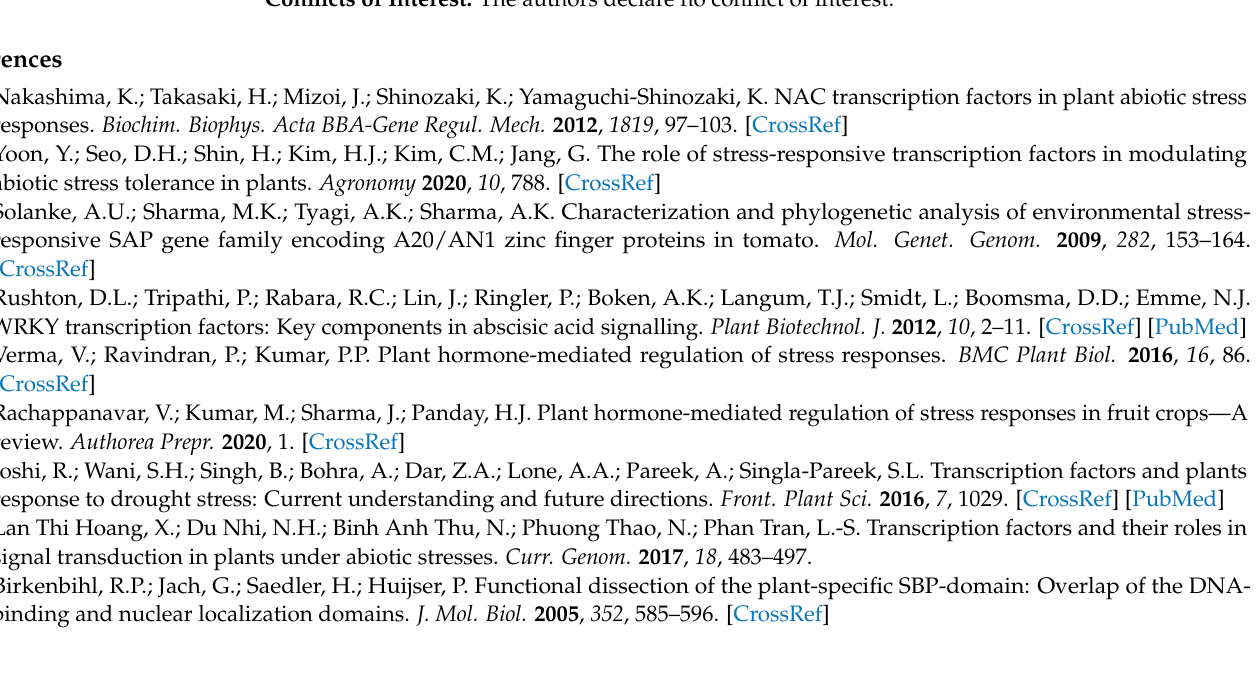
Figure S6. Differential gene expression of fruitlets in almonds. Volcano plots of PdSAP expression in fruitlet of P. dulcis are shown at day 32 after flowering. Supplementary Figure S7. Differential gene expression of fruitlets in almonds. Volcano plots of differential gene expression of PdSAP in almond’s fruitlet are shown at day 37 after